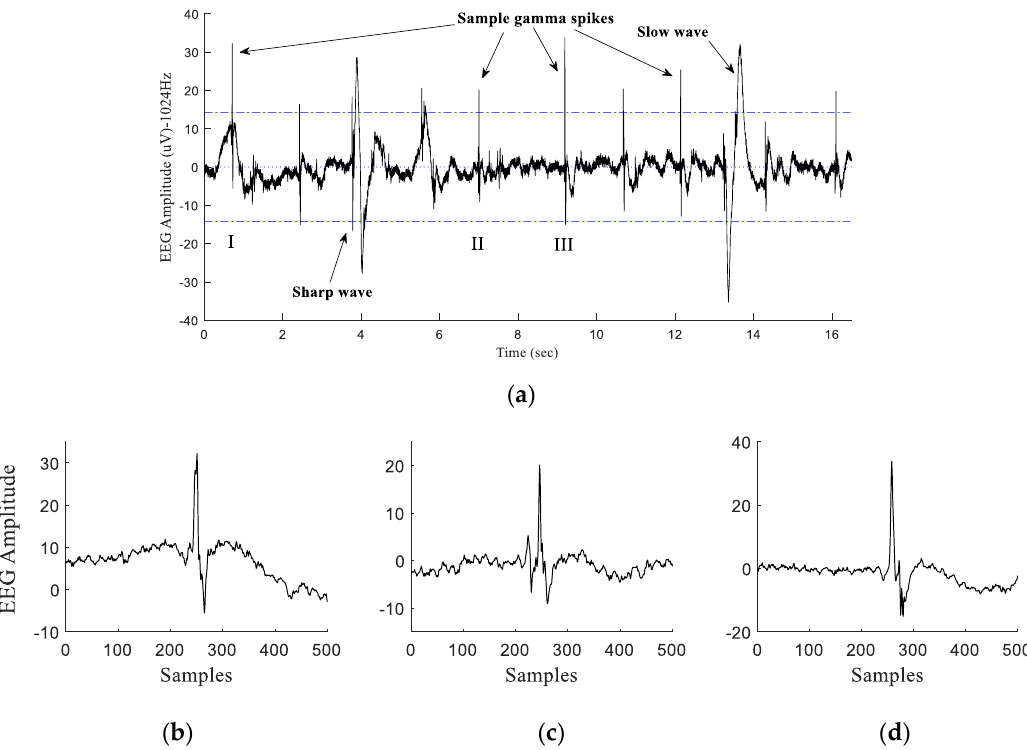
Figure 1. ( a ) A sample 16-sec electroencephalogram (EEG)/electrocorticogram (ECoG) recorded at 1024 Hz, 90 min post-hypoxic – ischemic (HI) insult containing gamma spikes, a sharp wave, and a slow wave. ( b ), ( c ), and ( d ) represent the (I), (II), and (III) sample labelled HI spike transients.